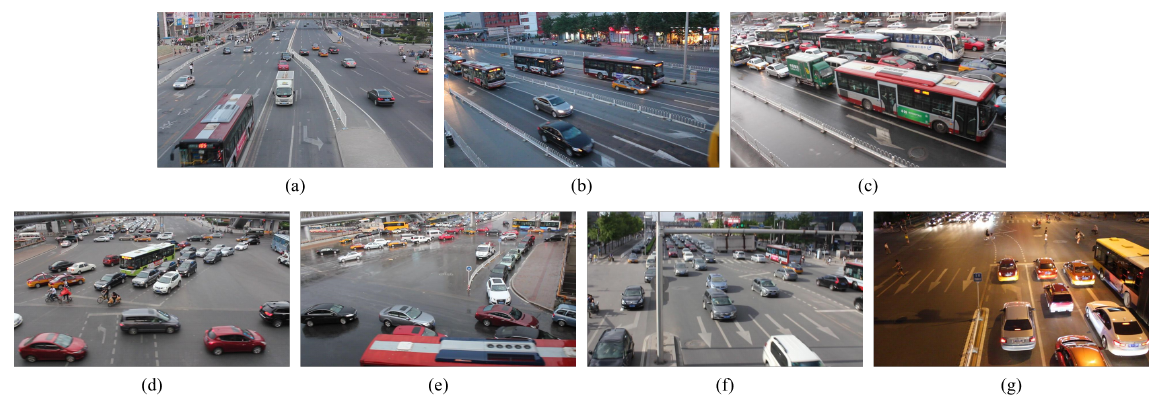
Figure 5. Sampled frames from each category of the UA-DETRAC-test subsets: ( a ) easy; ( b ) medium; ( c ) hard; ( d ) cloudy; ( e ) rainy; ( f ) sunny; ( g )